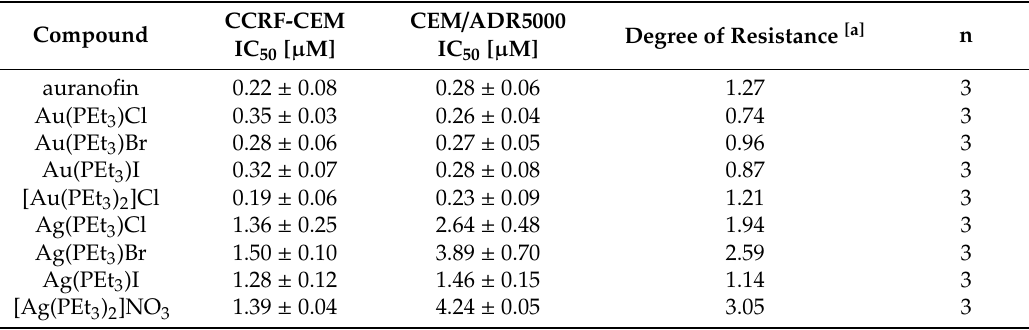
Table 1. Inhibitory e ff ects (IC 50 values ± SD) of the investigated compounds on cell growth